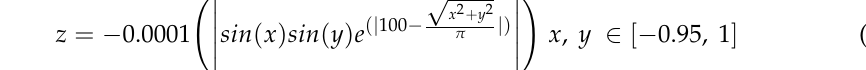
| relationship to the average